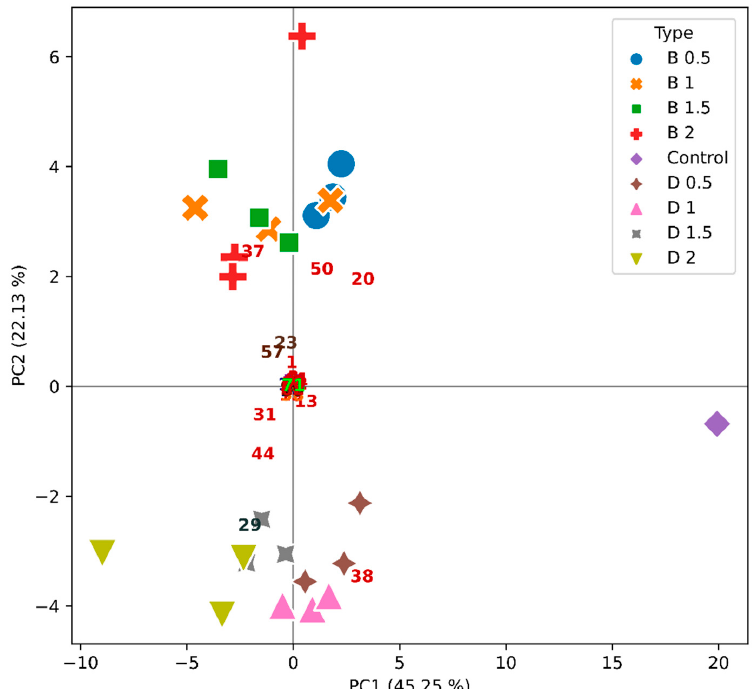
Figure 7. PCA illustrating the simultaneous projection of the wine samples (objects)—by a mark, and VOCs (variables) loadings—by a number, for the Encruzado varietal wine. The different concentrations of bentonite (B) or DCMC (D) in g/L are indicated.